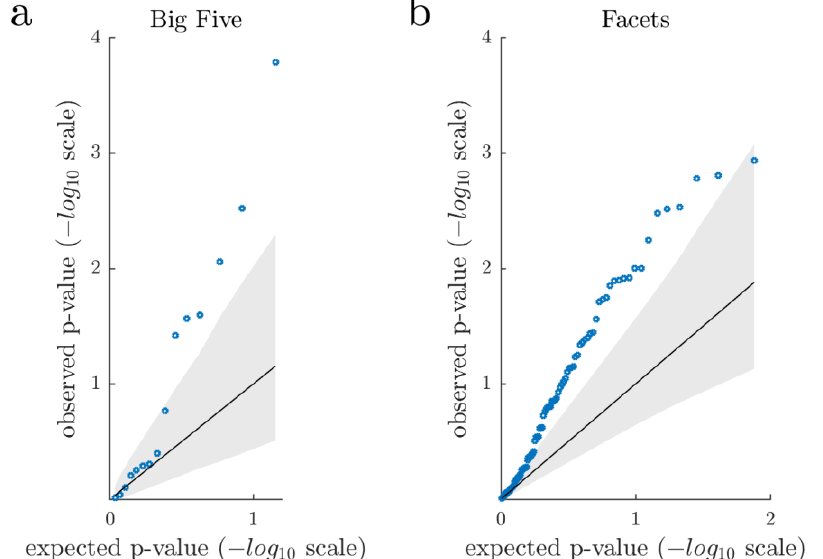
Figure 3. Permutation-based qq-plot showing the observed p -values from the association analyses (blue circles) sorted from largest to smallest and plotted against the expected p -values under the null hypothesis. The solid diagonal line represents the mean expected p -values. The lower and upper bound of the grey area represents the 5th and 95th percentile (−log10 scale) of the expected p -values. Quantile-quantile plots show an excess of low p -values, suggesting that association analyses revealed overall stronger evidence than expected under the null hypothesis of no effect. ( a ) NEO personality traits (sex and age-normalized T-scores) ( b ) NEO personality facets (sex and age-normalized T-scores).